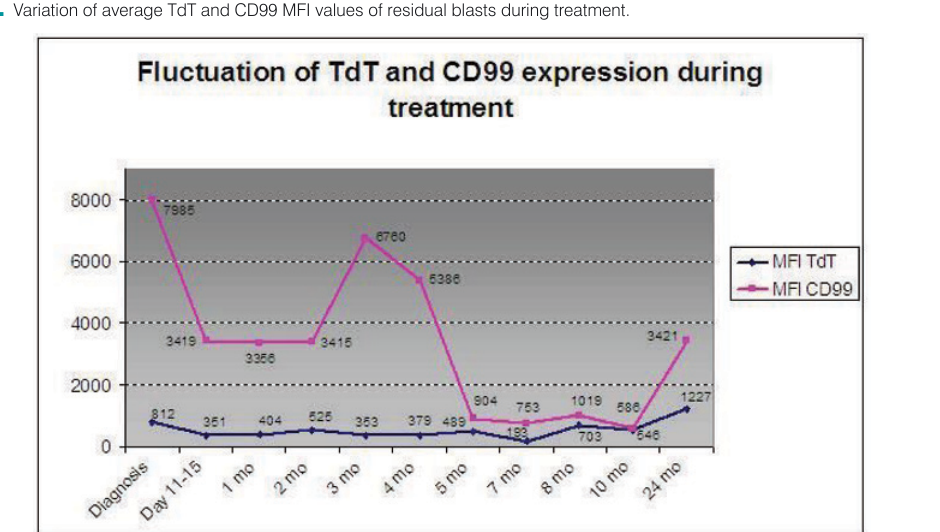
Figure 6. Variation of average TdT and CD99 MFI values of residual blasts during